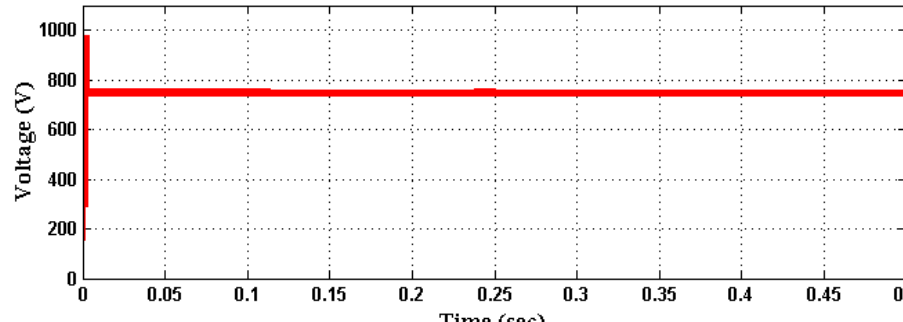
Figure 12. DC voltage of converter.